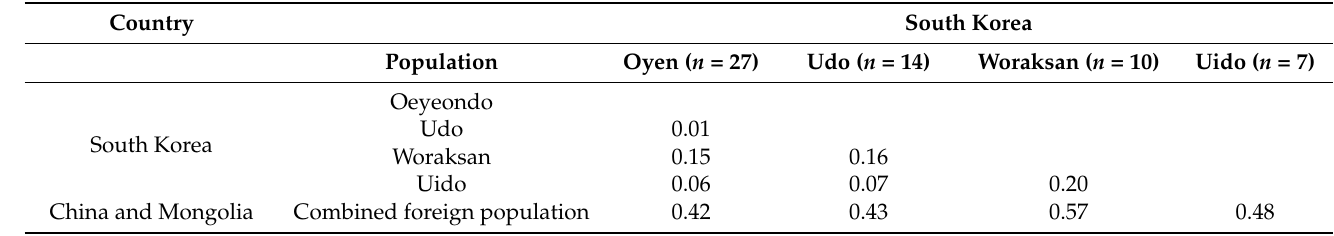
Figure 3. Median-joining haplotype network of 18 concatenated mitochondrial DNA ( Cytb + ND4 ; 1809 bp) haplotypes of 15 Orientocoluber spinalis populations from South Korea, China, and Mongolia. The sizes of nodes (circles) are proportional to the number of individuals. Black dots represent median vectors inferred and unsampled haplotypes. Mutation steps between two haplotypes were indicated by diagonals. Table 4. Uncorrected pairwise genetic p -distances (%) between the four major Orientocoluber spinalis populations in South Korea and the combined foreign population consisting of three populations in China and one population in Mongolia based on concatenated mitochondrial DNA ( Cytb + ND4 ; 1809